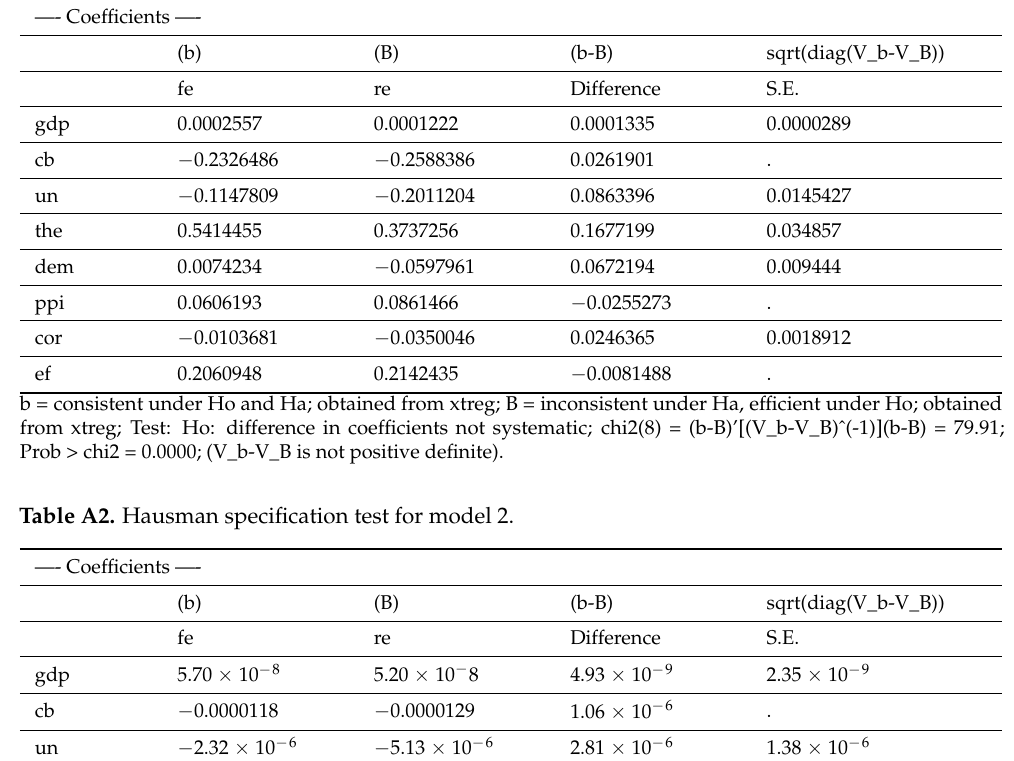
Table A1. Hausman specification test for model 1.